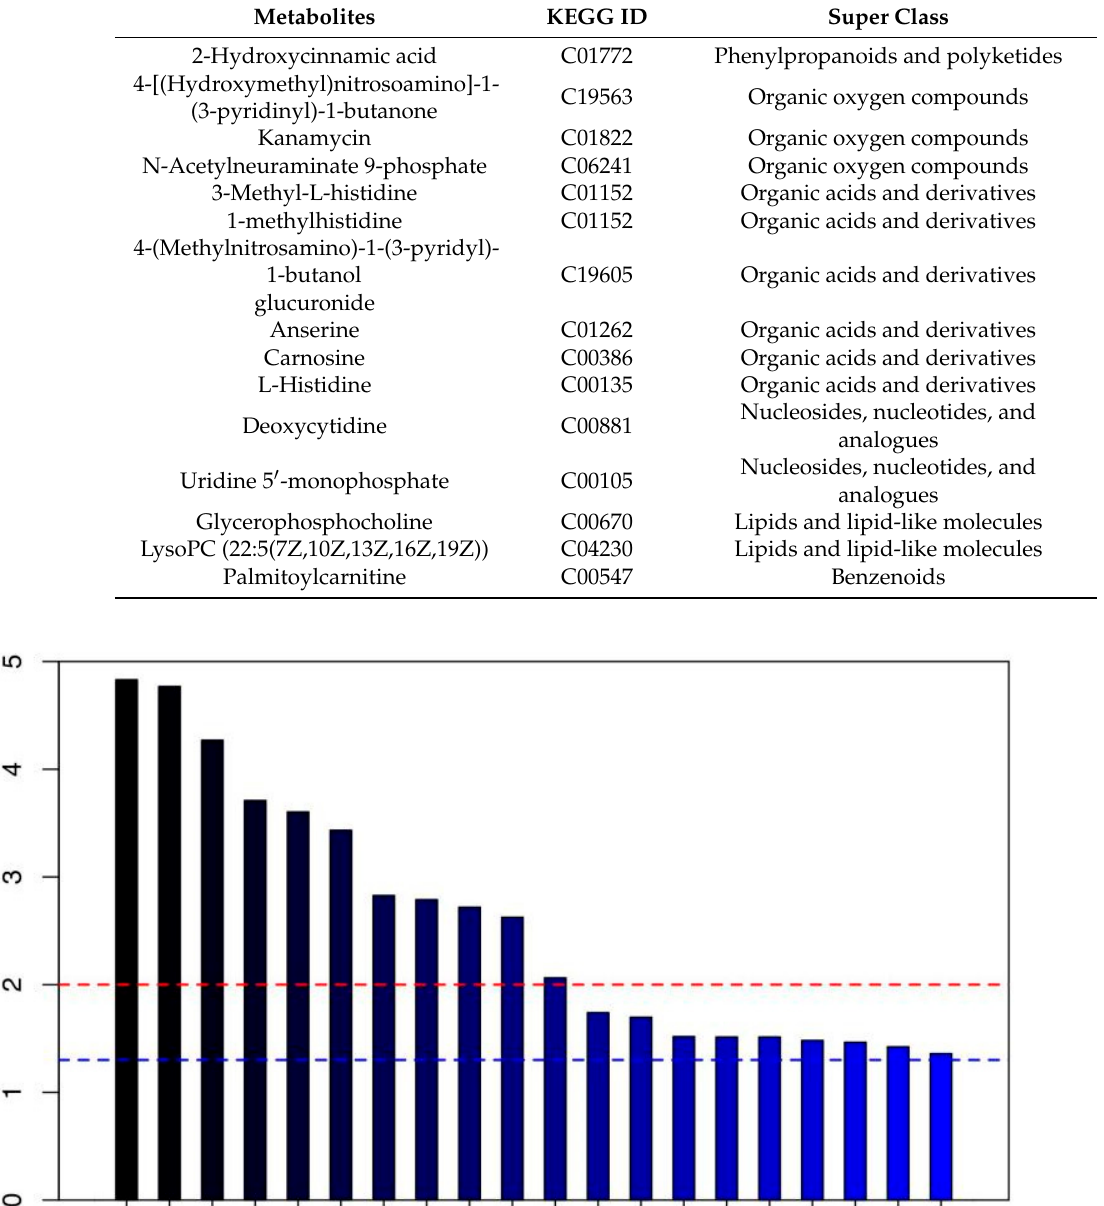
Table 2. Downregulation of differential metabolites and their classification.